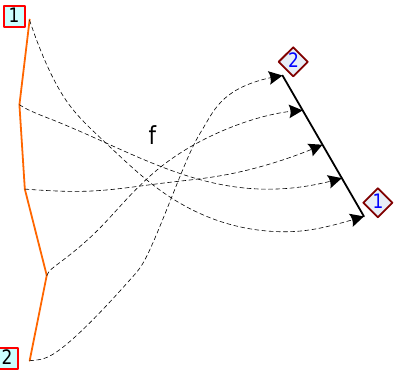
Figure 5. An example of the ―chord‖ length method.